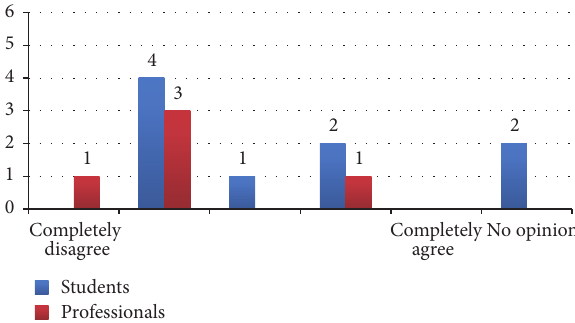
Figure 11: Statement: different groups performing ECW/PUEA on the same product will come to the same